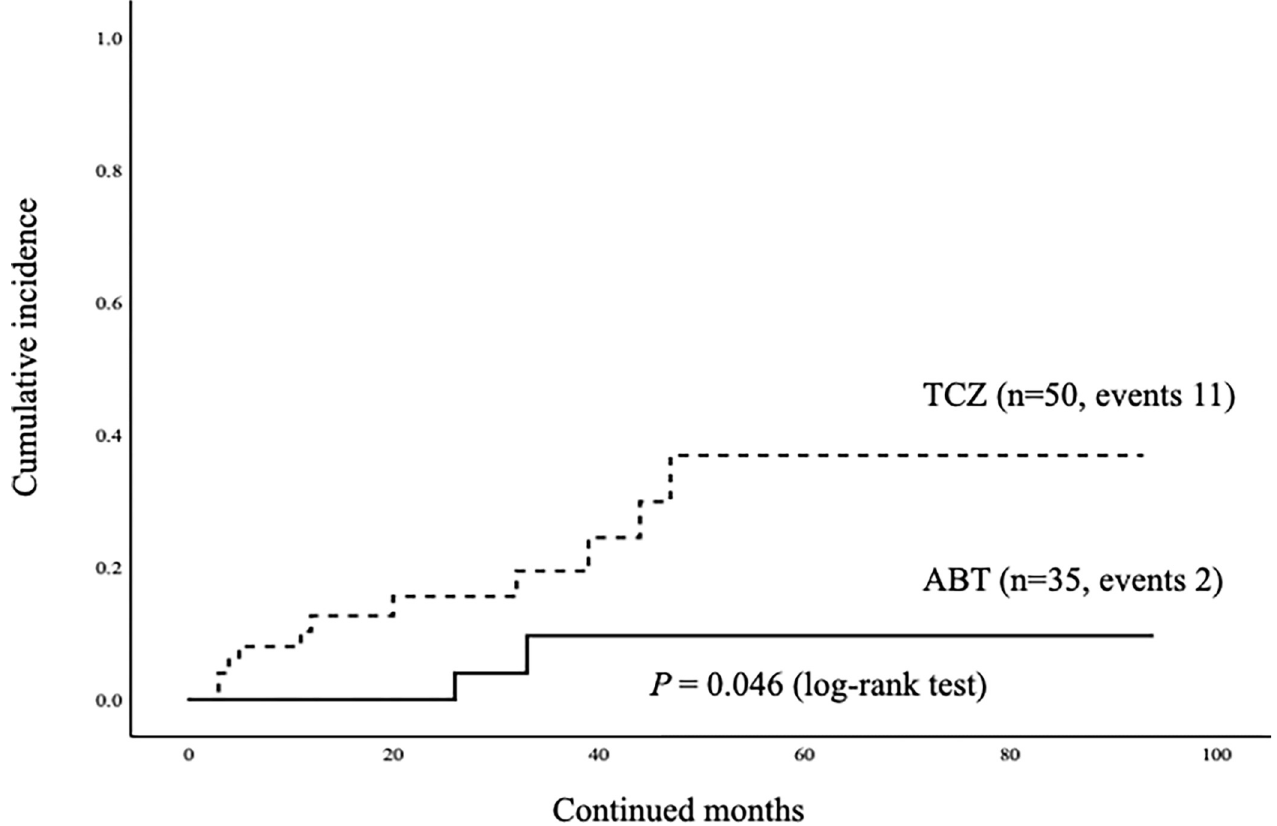
Fig 9. The cumulative incidences of discontinuation of ABT or TCZ in EORA patients due to adverse. The rates of discontinuation of these biologics due to AEs were significantly higher in TCZ group compared to those in ABT group.